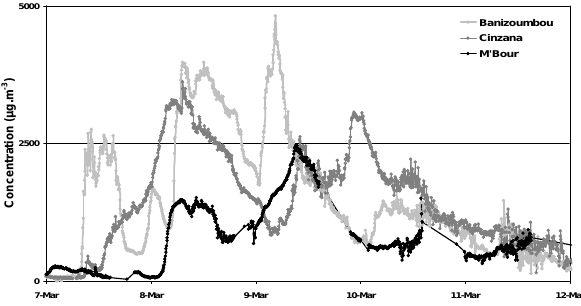
Fig. 10. 5-min mean PM 10 concentrations measured in Banizoum- bou (Niger), Cinzana (Mali) and M’Bour (Senegal) from 7 to 12 March